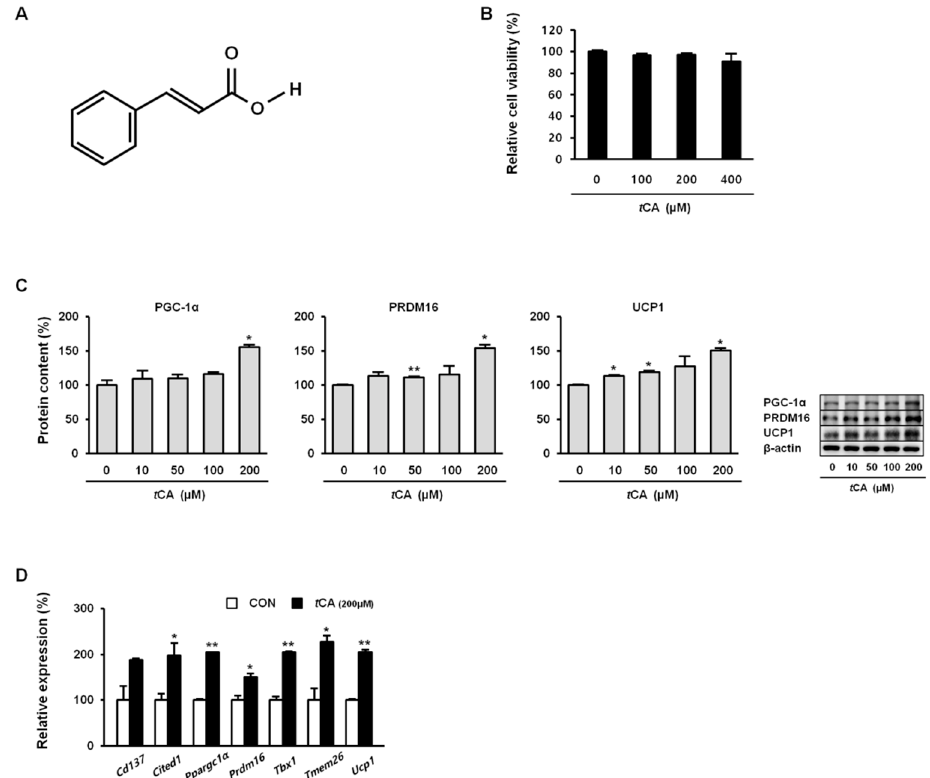
Figure 1. Trans -cinnamic acid ( t CA) induces browning in white adipocytes. Chemical structure of t CA ( A ) and cytotoxicity ( B ). t CA promotes increased protein content of core brown fat markers ( C ) in a dose-dependent manner as well as expression of beige fat-specific genes ( D ) at 200 µ M in 3T3-L1 adipocytes. Data are presented as the mean ± SD, and differences between groups were determined using the Statistical Package of Social Science (SPSS, version 17.0; SPSS Inc., Chicago, IL, USA) program, followed by Tukey’s post-hoc tests or Student’s t -test. Statistical significance between control and t CA-treated 3T3-L1 cells are shown as * p < 0.05 or ** p < 0.01.